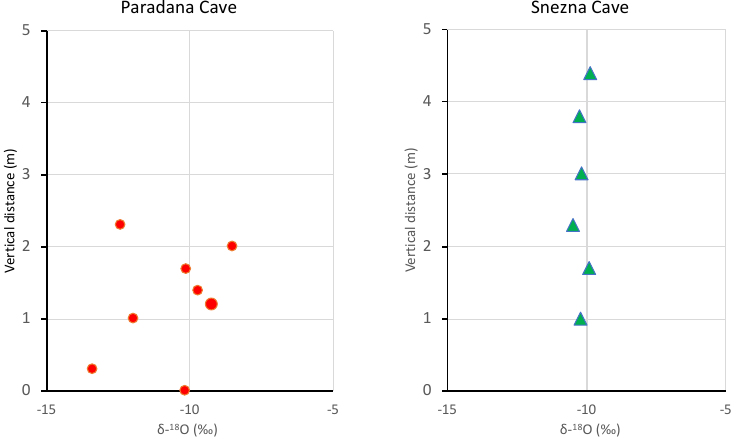
Figure 5. Vertical profiles of δ 18 O in cave ice in Paradana Cave and Snežna Cave. The error bars for the samples are smaller than the symbol size.